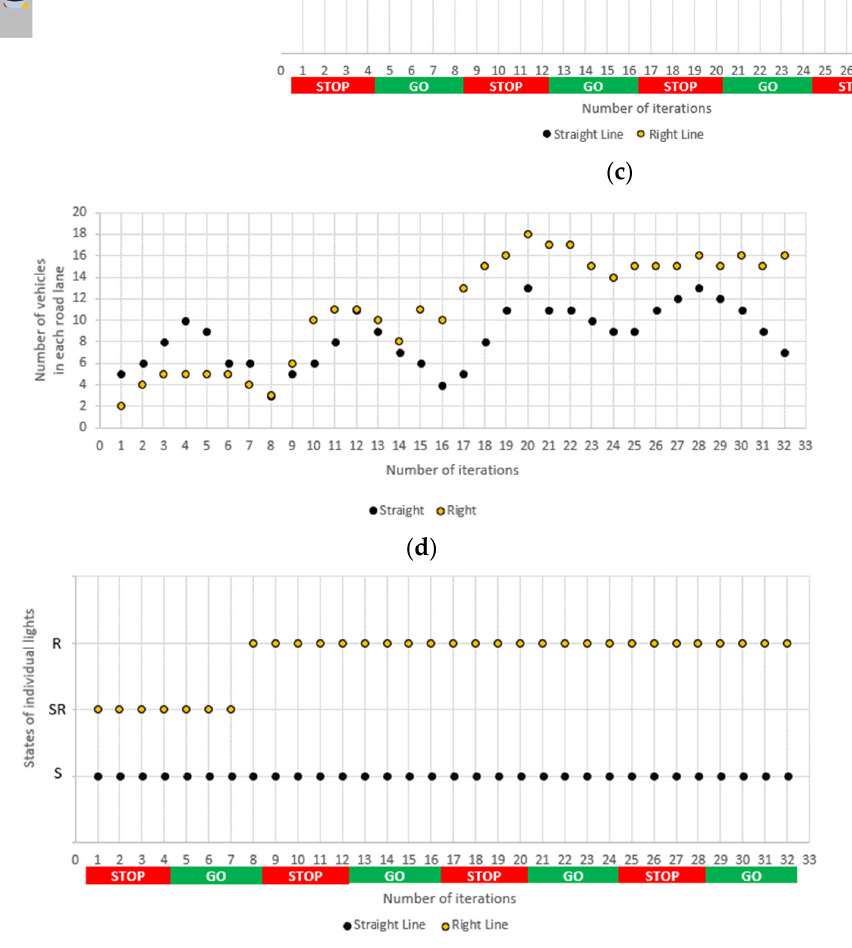
Figure 9. Intersection with two traffic lanes: ( a ) Layout of the intersection; ( b ) Number of vehicles with a declared direction of travel–option I; ( c ) Changing states of lights in individual iterations of the simulation–option I; ( d ) Number of vehicles with a declared direction of travel–option II; ( e ) Changing states of lights in individual iterations of the simulation–option II.